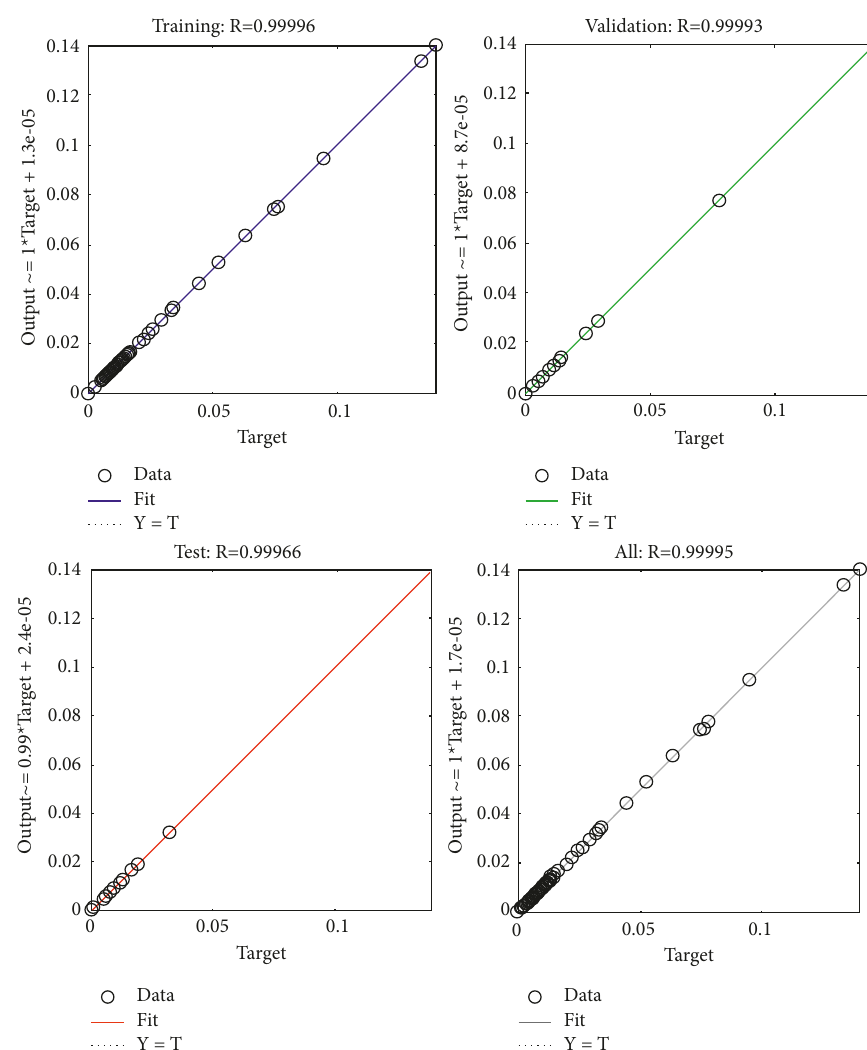
Figure 8: The training, validation, testing, and final total correlation coefficient